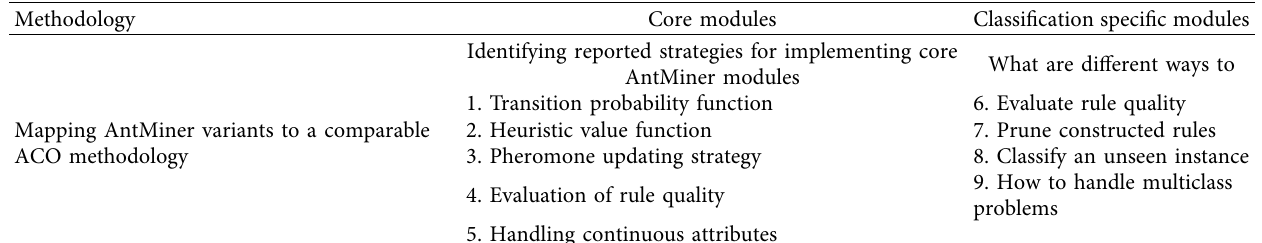
Table 1: Framework for reviewing existing methods.